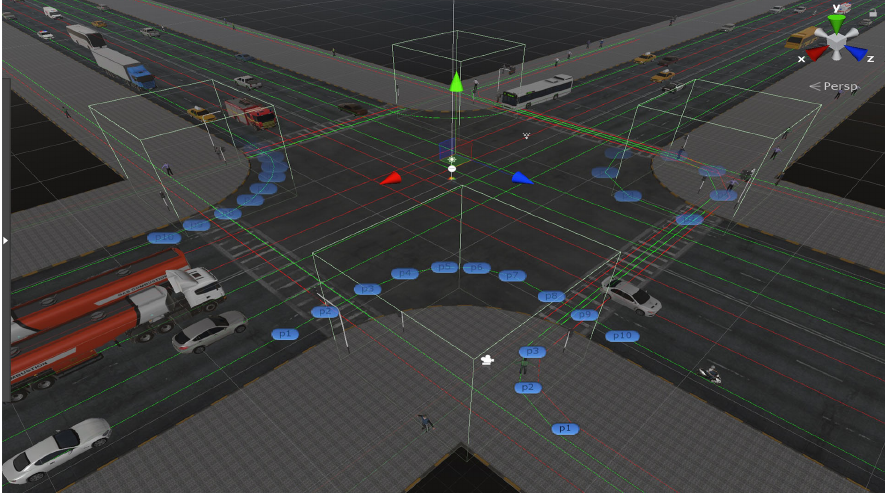
Figure 1. The invisible collider system is the main mechanic that the scoring system is built